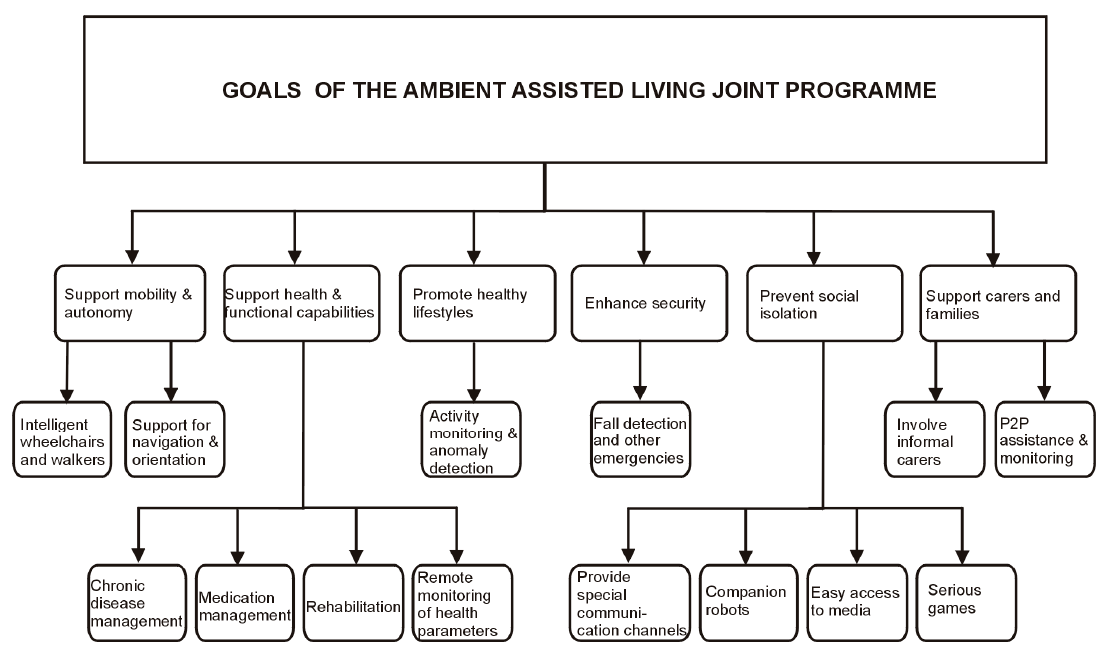
Figure 1. A taxonomy of the research directions in ambient assisted living (AAL) based on the objectives formulated by the AAL Joint Programme.